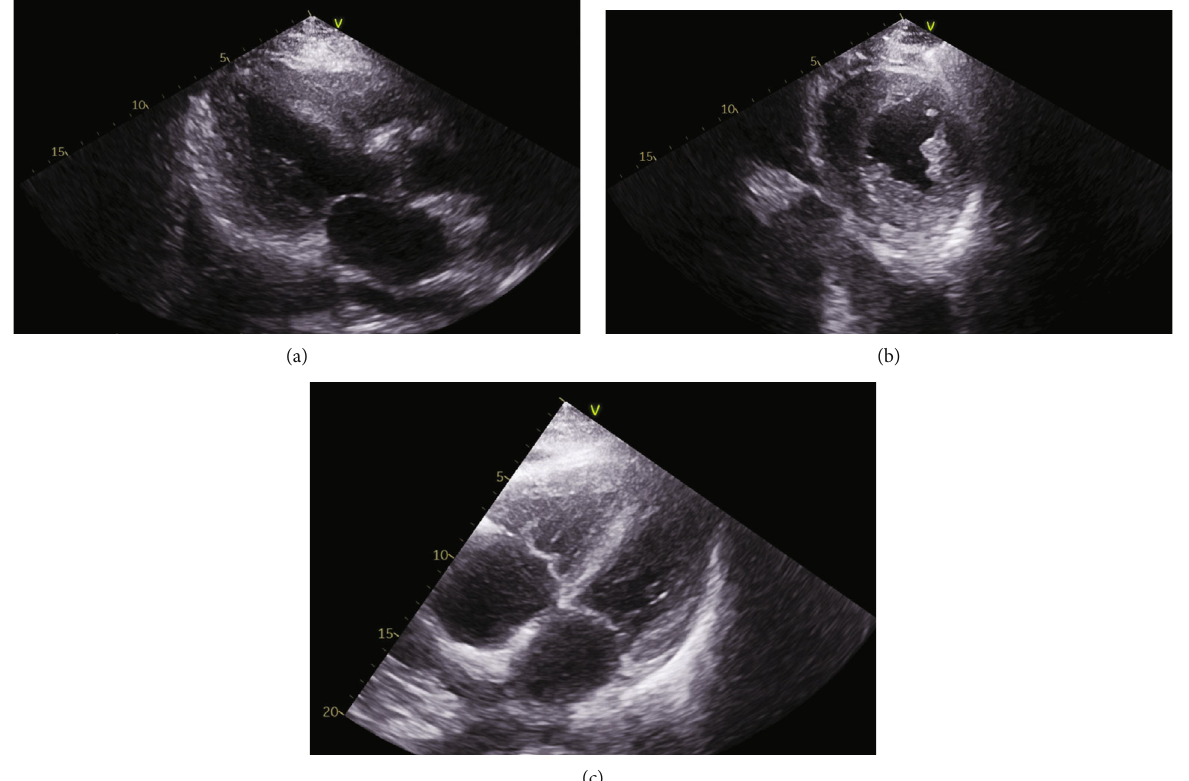
Figure 1: Previous echocardiogram (a). Parasternal long axis (b). Parasternal short axis (c). Apical four-chamber showing moderate concentric left ventricular hypertrophy, right ventricular dilation, and moderately dilated